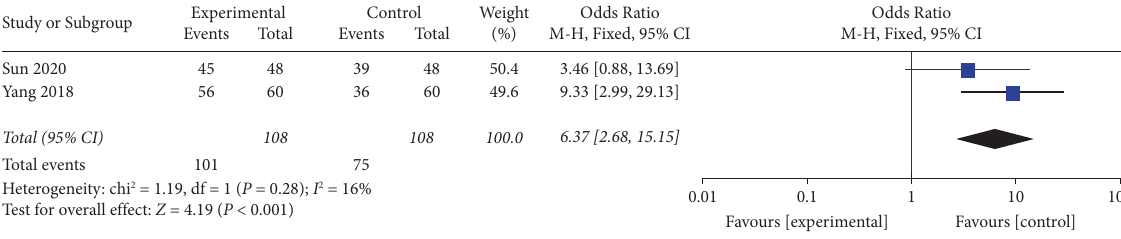
Figure 11: Comparison of the efective rate between the AA group and the control group.